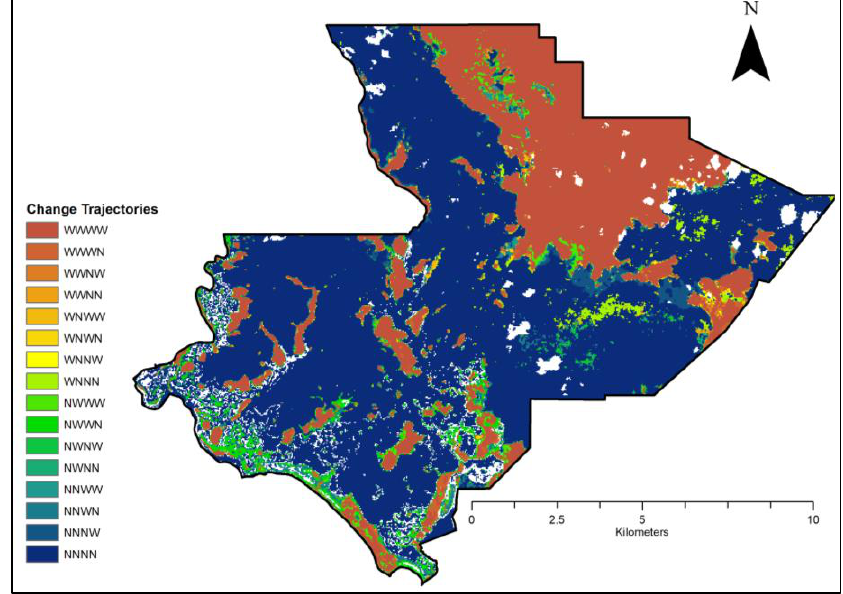
Figure 6. Overall change trajectory map using all four (1975, 1993, 2011, 2019) land cover classifications. Woody is “W” and non - woody is “N.” White pixels represent no data. Table 2. SVM classifier change trajectory pixel counts and percent change with explanation of each change trajectory. Woody is “W” and non - woody is “N”.